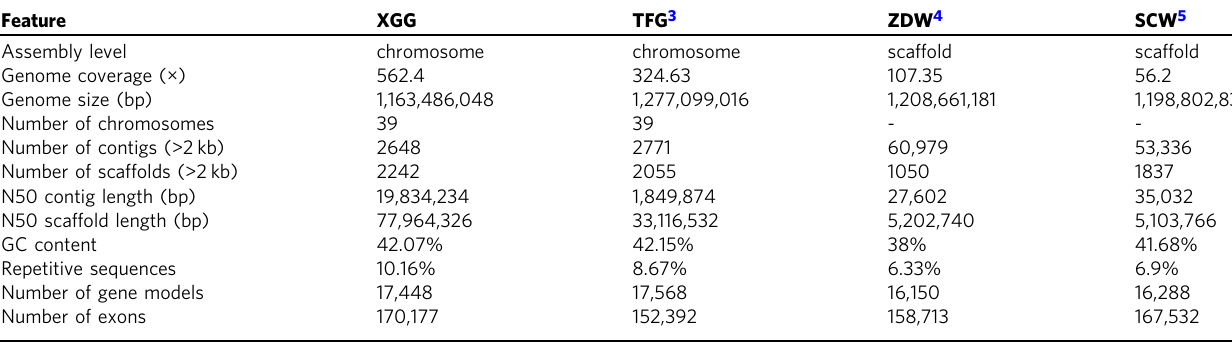
Table 1 Comparison of quality metrics within goose genome assemblies.